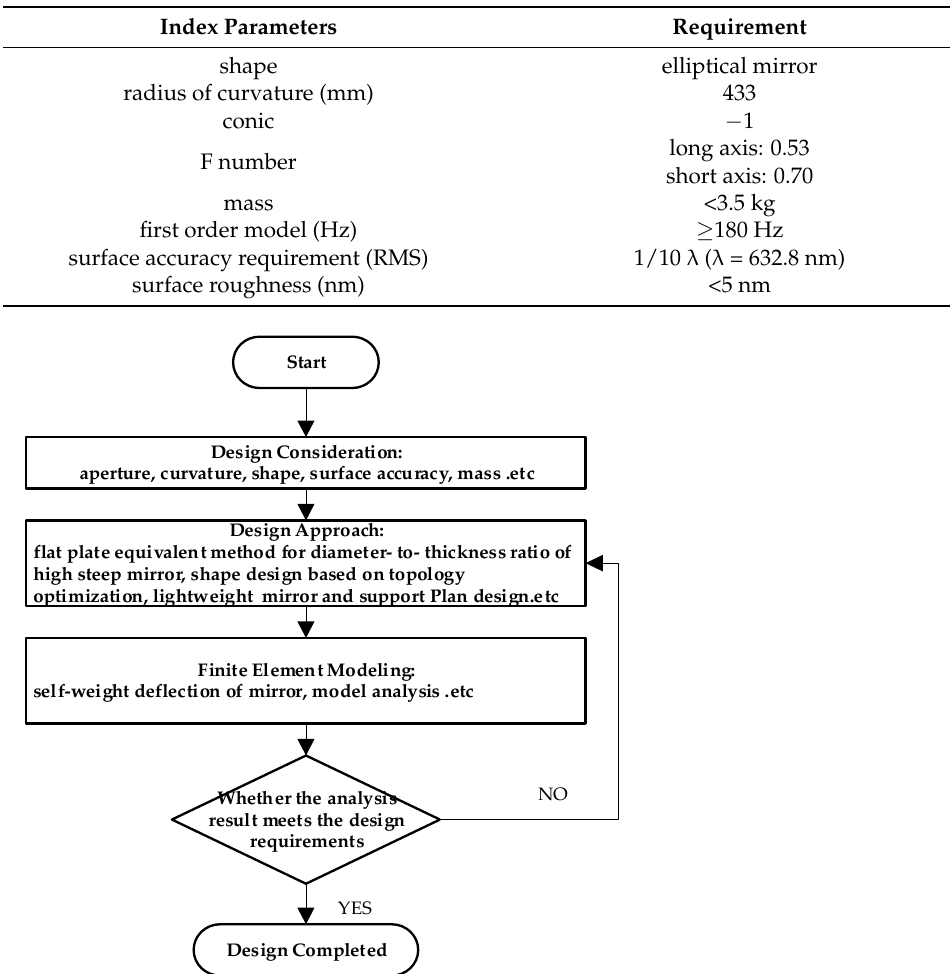
Figure 2. Flow chart of design scheme of a high-steepness lightweight elliptical mirror.